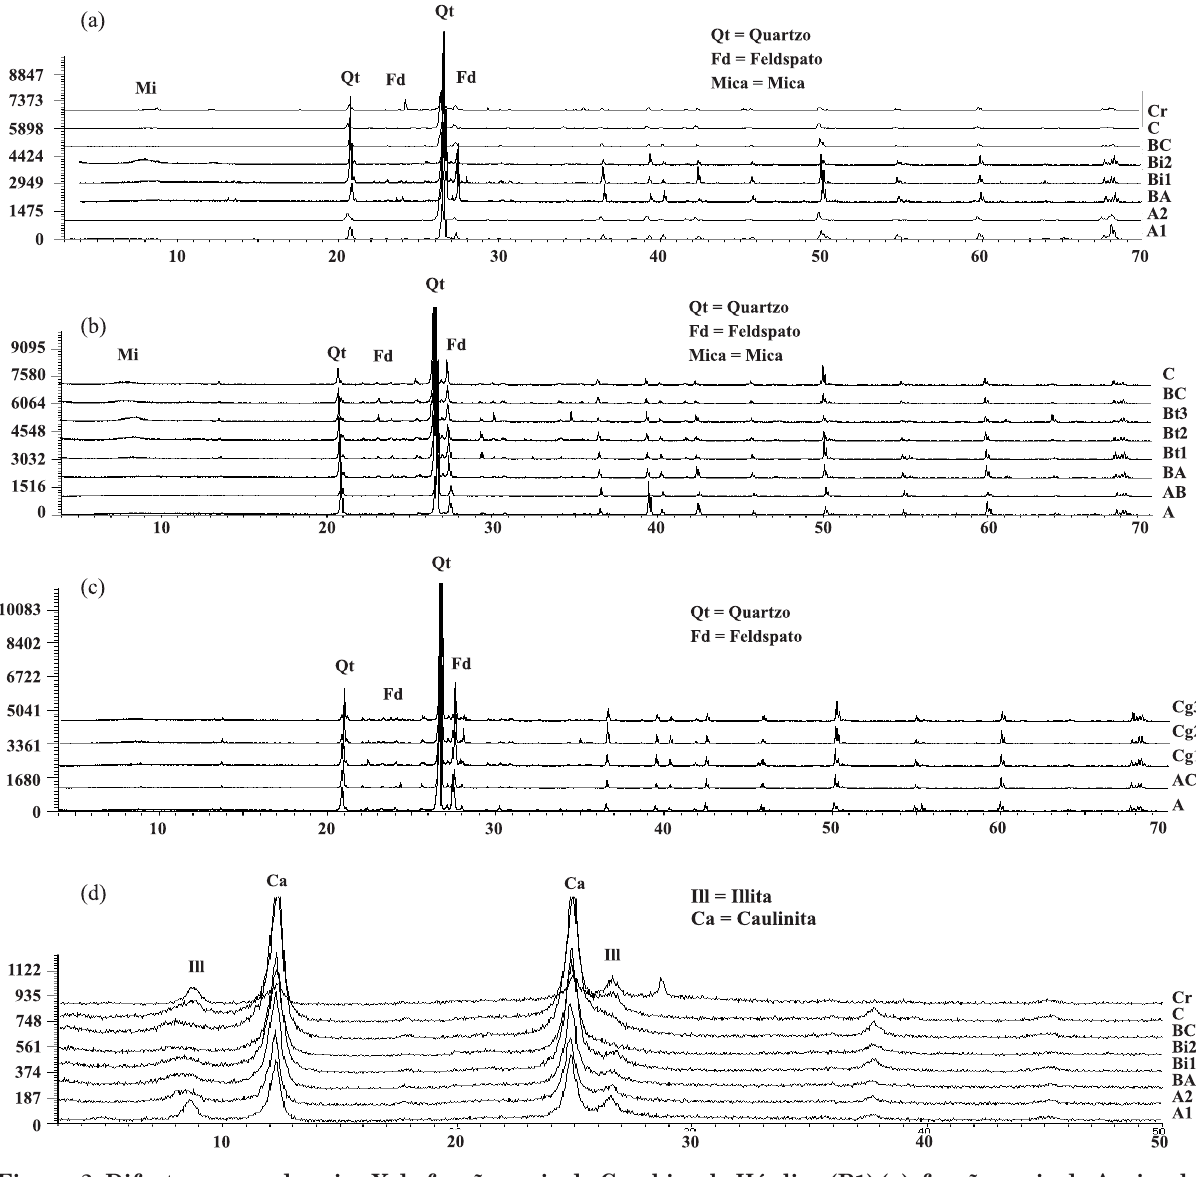
Figura 2. Difratogramas de raios X da fração areia do Cambissolo Háplico (P1) (a); fração areia do Argissolo Amarelo (P4) (b); fração areia do Gleissolo Háplico (P5) (c); fração argila do Cambissolo Háplico (P1)